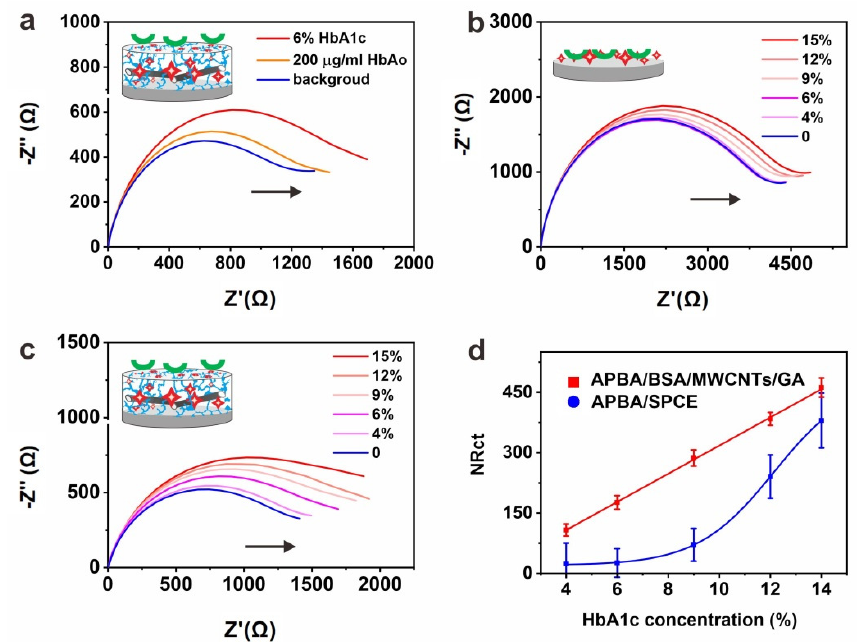
Figure 3. ( a ) EIS response of the APBA-BSA/MWCNTs/GA layer in the detection of HbAo and 6% HbA1c . (n = 3, only one EIs plot for each condition is shown); ( b ) EIS curve of the APBA layer in the detection of % HbA1c (contain HbAo ). (n = 3, only one EIS plot for each condition is shown); ( c ) EIS curve of the APBA-BSA/MWCNTs/GA layer in detection of % HbA1c (contain HbAo ). (n = 3, only one EIs plot for each condition is shown); ( d ) calibration curves as a function of % HbA1c for APBA layer and APBA-BSA/MWCNTs/GA layer. (n = 3, error bars represent the standard deviation of the mean).